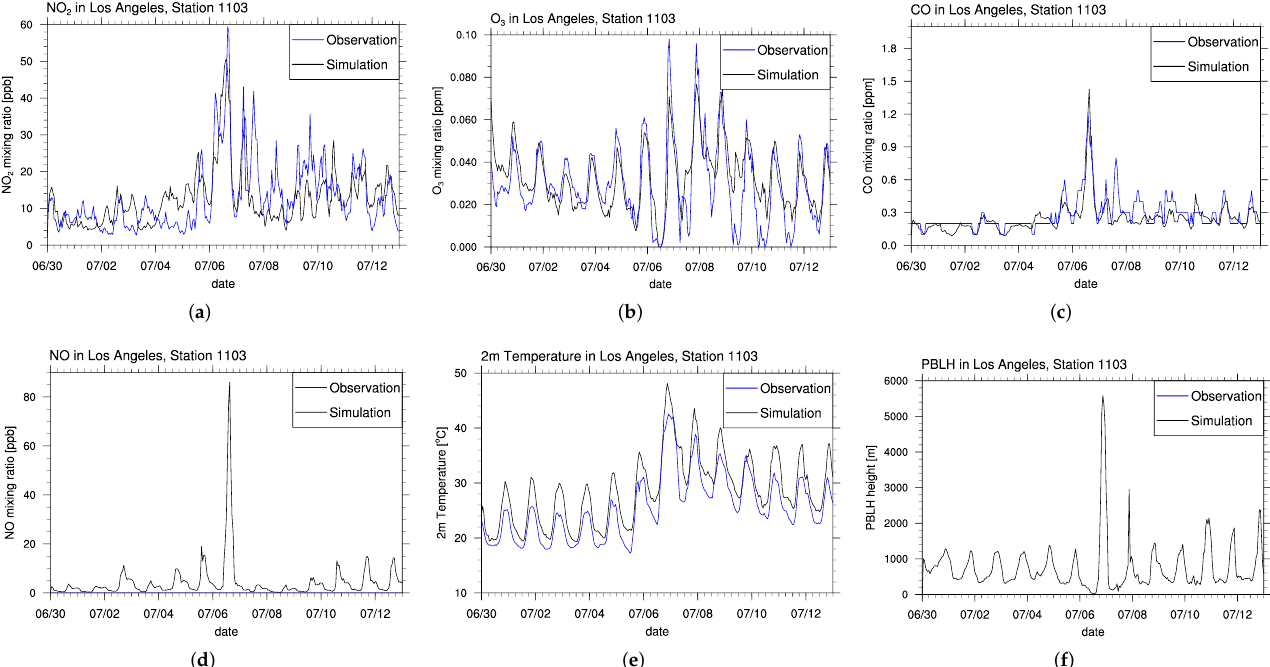
Figure 6. Comparison of in situ measurements with modeled variables at the ground at LA North Main Street in July 2018. No measurements for NO and the planetary boundary layer height are